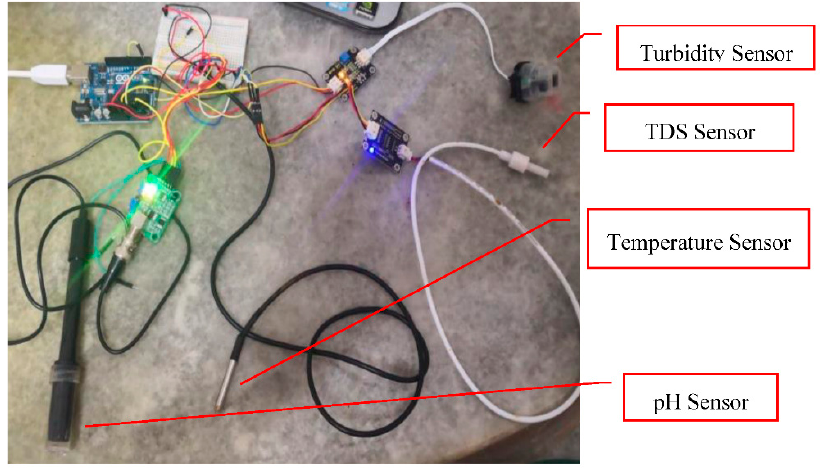
Figure 5. Setup of the Arduino-based sensor system. Table 2. Data for turbidity calibration.